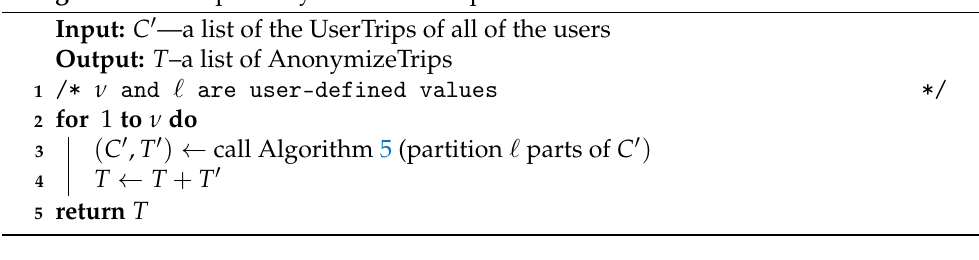
Algorithm 4: Trip Anonymization Component in PPTPF.